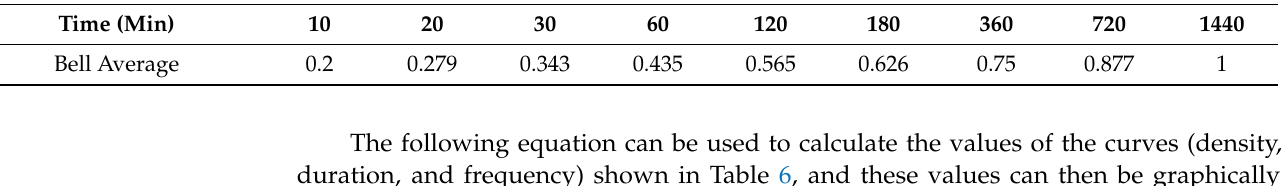
Table 5. Percentage of rainfall value at different periods (Bell’s Ratios).